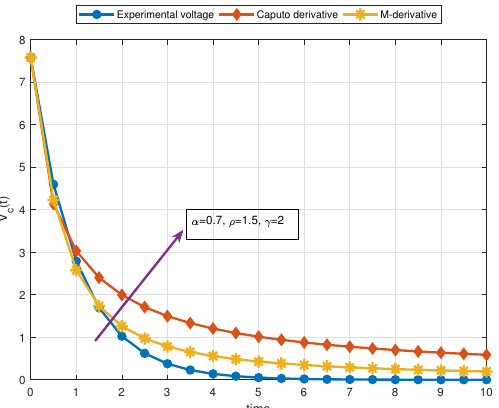
Figure 20. Comparison of the non-local M -derivative and Caputo derivative with experimental data for different values of α , ρ , and γ under the RC circuit including constant source when α = 0.7, ρ = 1.5, γ = 2, R = 10 Ω , C = 1000 F, e 0 = 0, and V c ( 0 ) =